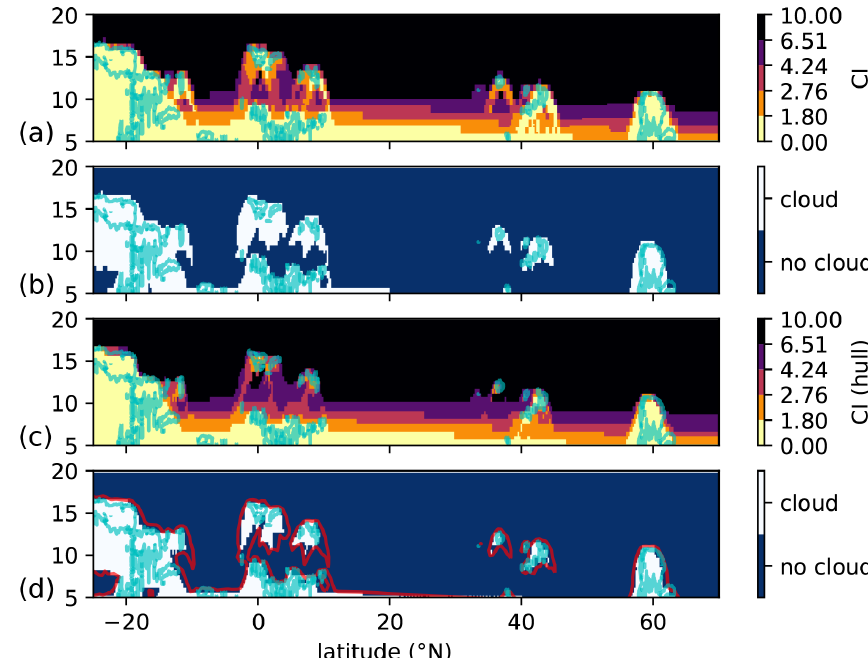
Figure 4. Result of the convex hull CI algorithm for IRLS simulations based on CALIOP extinctions reduced by a factor of 10. Panel (a) shows the CI at the location of the tangent points. Panel (b) shows the location of clouds according to the altitude-dependent CI threshold. Panel (c) shows the CI determined with the convex hull CI algorithm. Panel (d) shows the location of clouds according to the altitude- dependent CI threshold. The cloud position from (b) is shown as a red contour line for reference. The contour line for a “true” extinction value of 10 − 3 km − 1 is shown as a light blue line in all panels. The satellite looks northwards in these